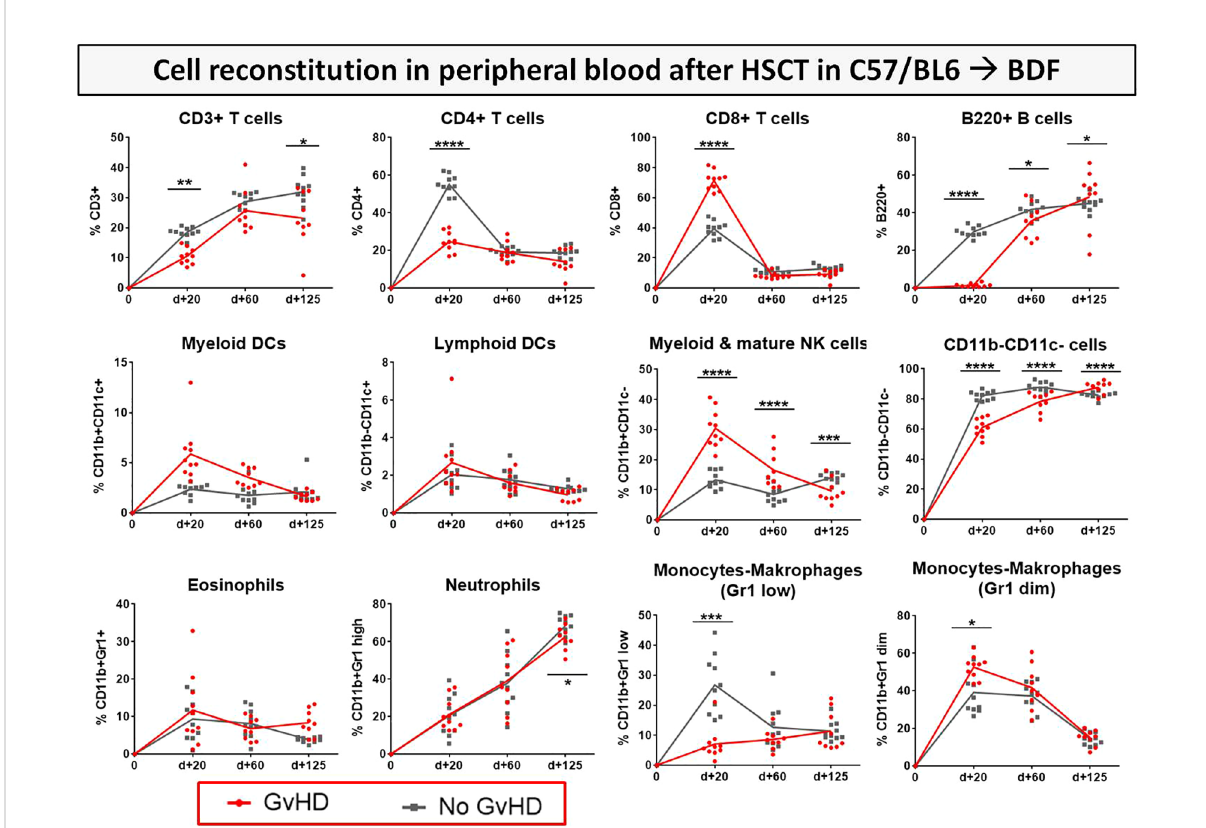
FIGURE 8 Immune cell reconstitution in peripheral blood of BDF1-recipients over 125 days after allo- vs. syn HCT. Tail vein blood was collected at three time points, PB cells were isolated, stained with the respective FACS-antibodies and samples were analyzed with fl ow cytometry. DCs, dendritic cells; NK, natural killer cells; dim, diminished. n=9 (cGvHD); n=10 (No GvHD). Representative data from one out of four experiments. *P<0.05, **P<0.01, ***P<0.001, ****P<0.0001 by unpaired students